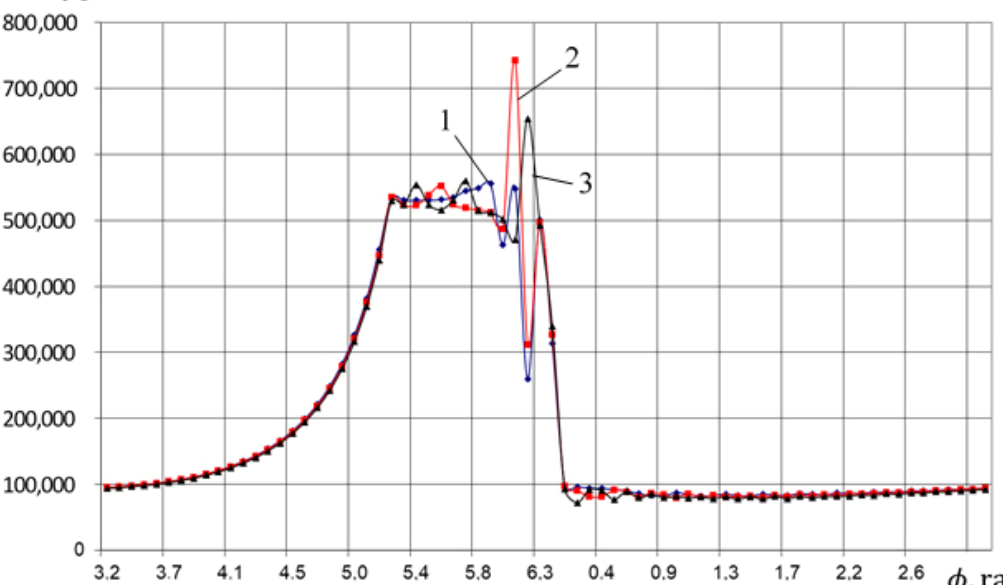
Figure 19. The indicator diagram of the compressor section at different speeds of the crankshaft (1— n rev = 400 rpm; 2— n rev = 500 rpm; 3— n rev = 600 rpm ).